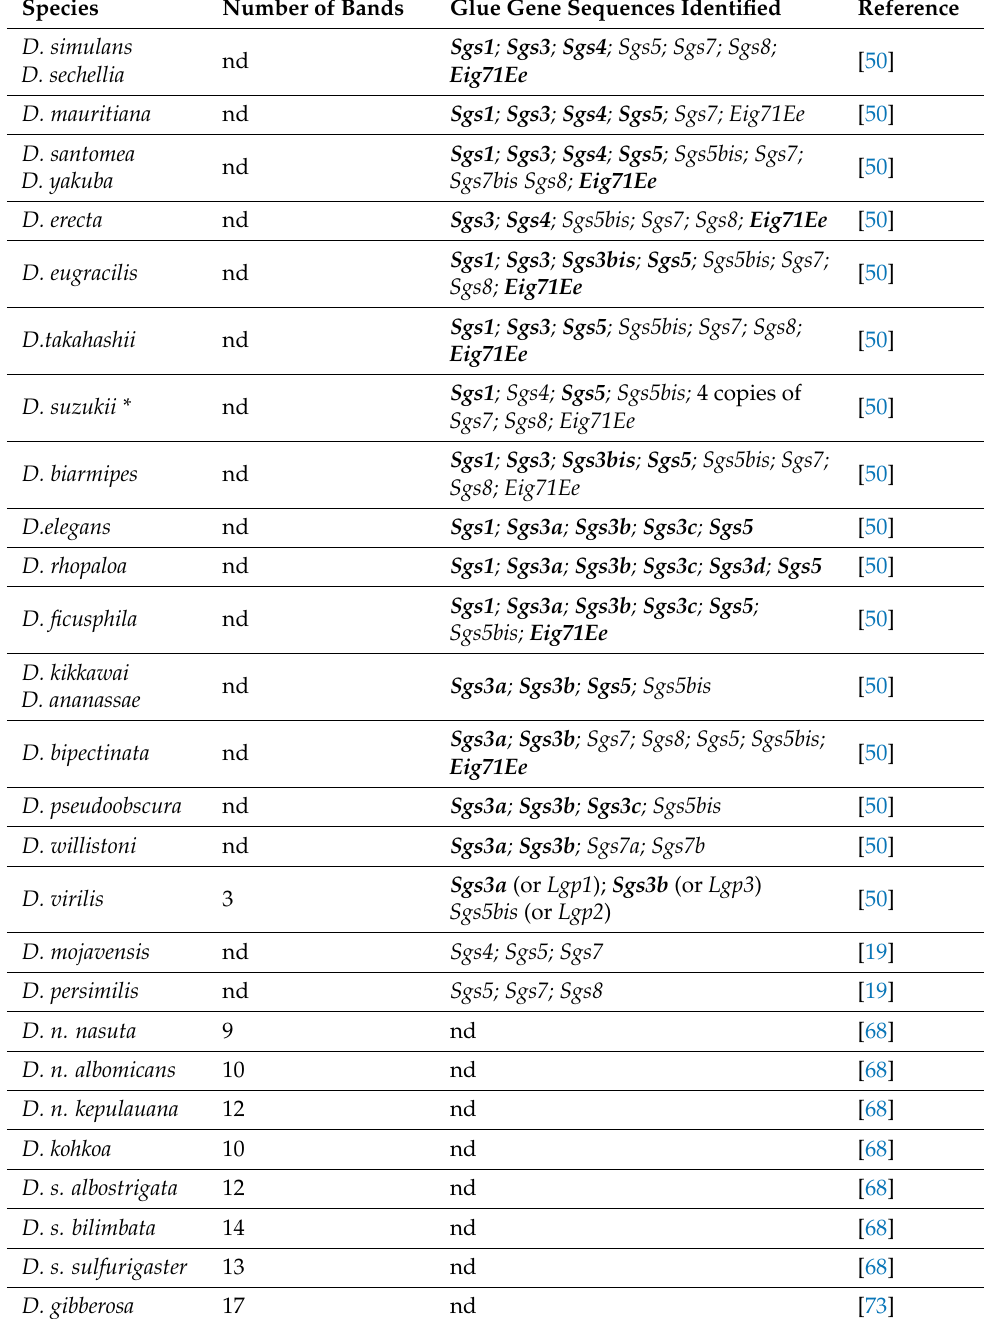
Table 2. List of the glue genes and glue protein bands identified in Drosophila species. Sgs genes written in bold correspond to proteins with internal repeats rich in serines, threonines and prolines. * An updated genome assembly [72] shows that D. suzukii actually contains one Sgs3 gene and only one copy of Sgs7 (data not shown). Nd: not